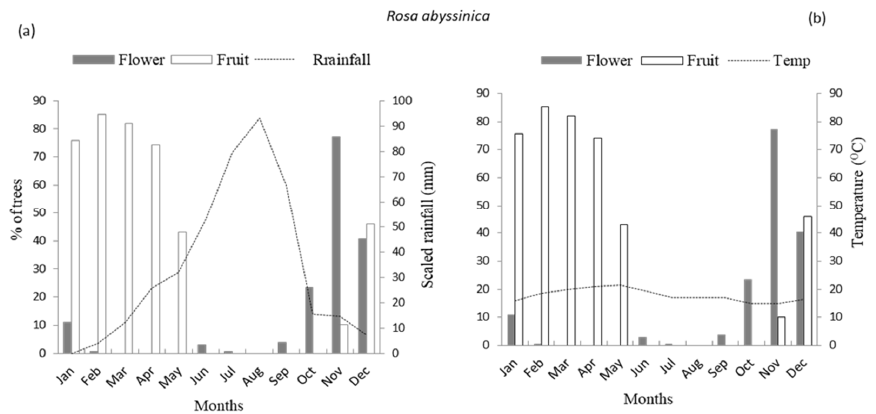
Figure 7. Percentage of flowering and fruiting of Rosa abyssinica in relation to: ( a ) monthly precipi ‐ tation and ( b ) average temperature. In which Jan = January, Feb = February, Mar = March, Apr = April, May = May, Jun = June, Jul = July, Aug = August, Sep = September, Oct = October, Nov = November, Dec = December.